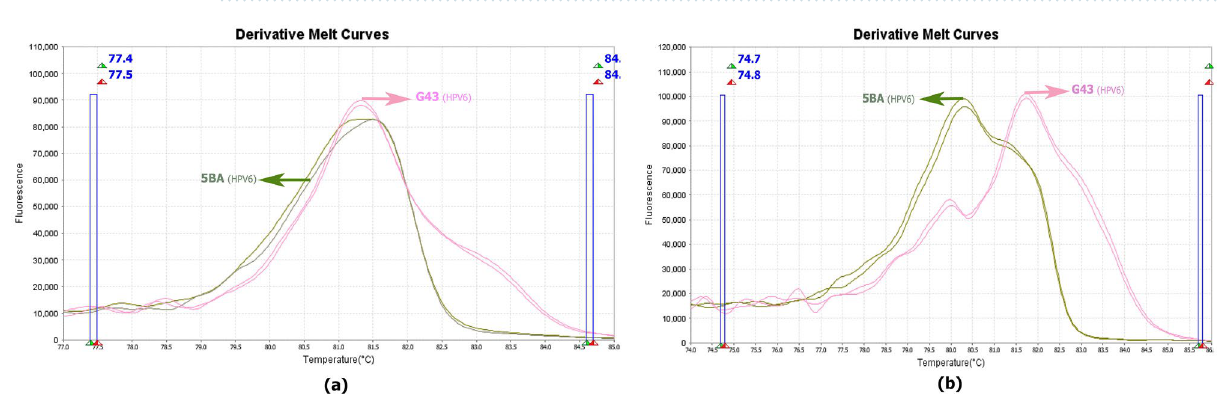
Figure 8. The derivative melt curve released from HPV discrimination using approach one is related to isolates 5BA and G43 ( a ). Derivative melt curve released from HPV discrimination using approach two, related to isolates 5BA and G43 ( b